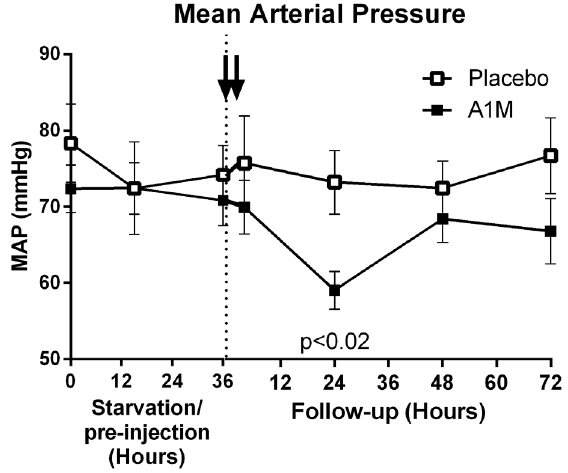
Figure 2. Physiological parameters. The mean arterial blood pressure was monitored non-invasively. The arrows indicate the A1M injections. The data are presented as mean 6 SEM. The indicated p- value is valid for the 24 hours re-fed follow-up time point and calculated using un-paired t-test.